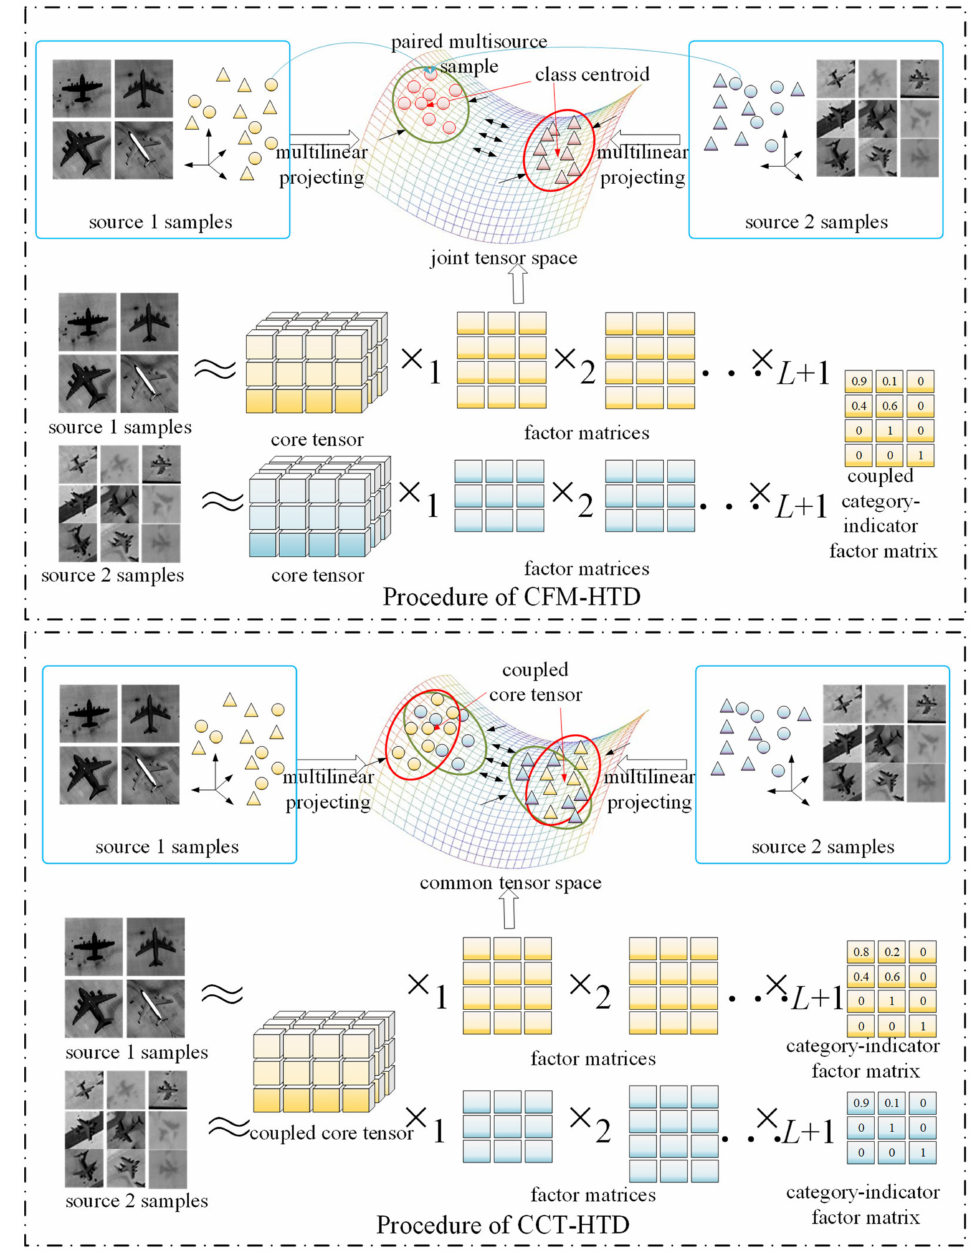
Figure 1. Illustration of the procedure of the proposed coupled heterogeneous Tucker decomposition. The upper one refers to the procedure of CFM-HTD, and the lower one refers to the procedure of